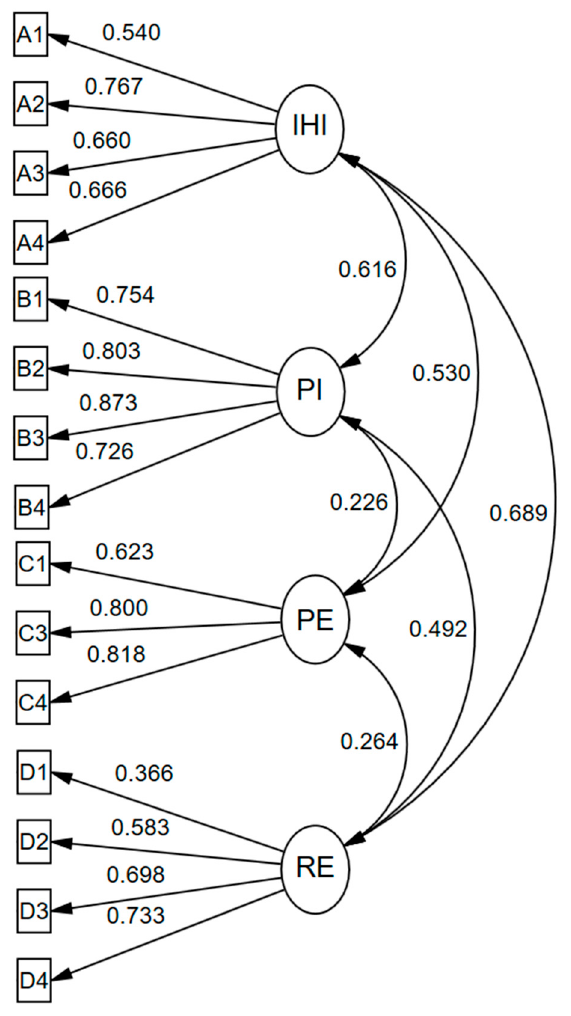
Figure 1. The results of standardized estimates for DEFS structures.